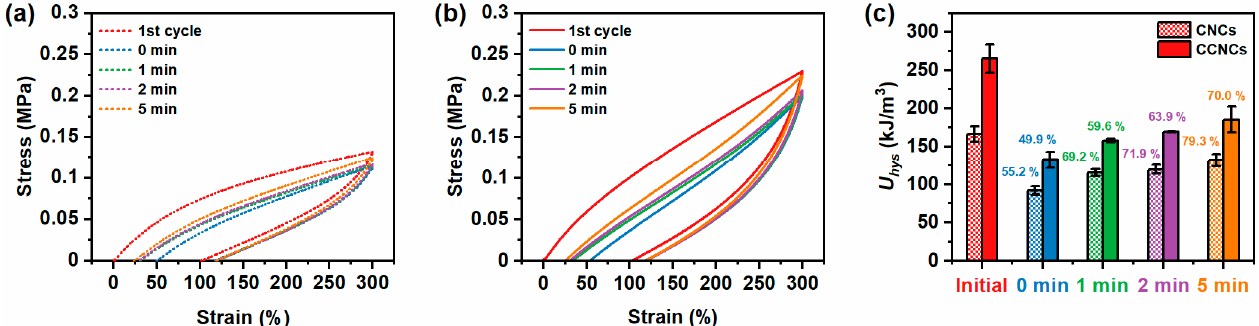
Figure 6. Self-recovery of the nanocomposite hydrogels after different resting times. ( a ) CNC (12 wt.%) nanocomposite hydrogels. ( b ) CCNC (7 wt.%) nanocomposite hydrogels. ( c ) Recovered U hys at different resting times.